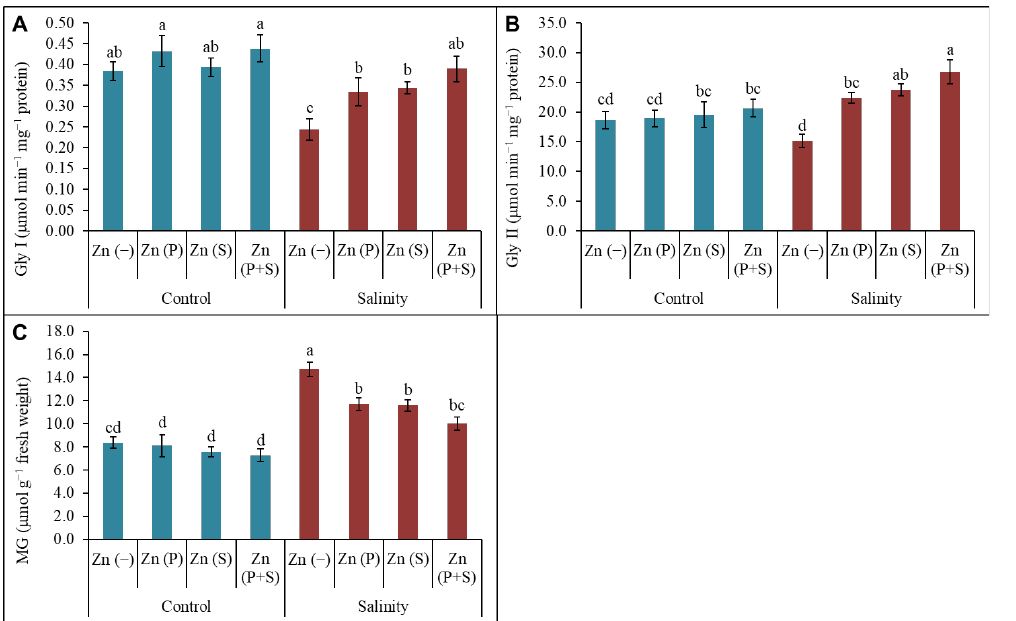
Figure 7. Activity of Gly I ( A ) and Gly II ( B ) and content of MG ( C ) of soybean plants induced by Zn supplementation. Twenty five-day-old plants were subjected to salt (150 mM NaCl) and supplemented with Zn (1 mM ZnSO 4 · 7H 2 O). P and S indicate seed priming and foliar application with Zn, respectively. Control treatments were grown with water. Mean ( ± SD) was calculated from three replicates for each treatment. Different letters of bars indicate significant differences at p ≤ 0.05 applying Tukey’s HSD test.